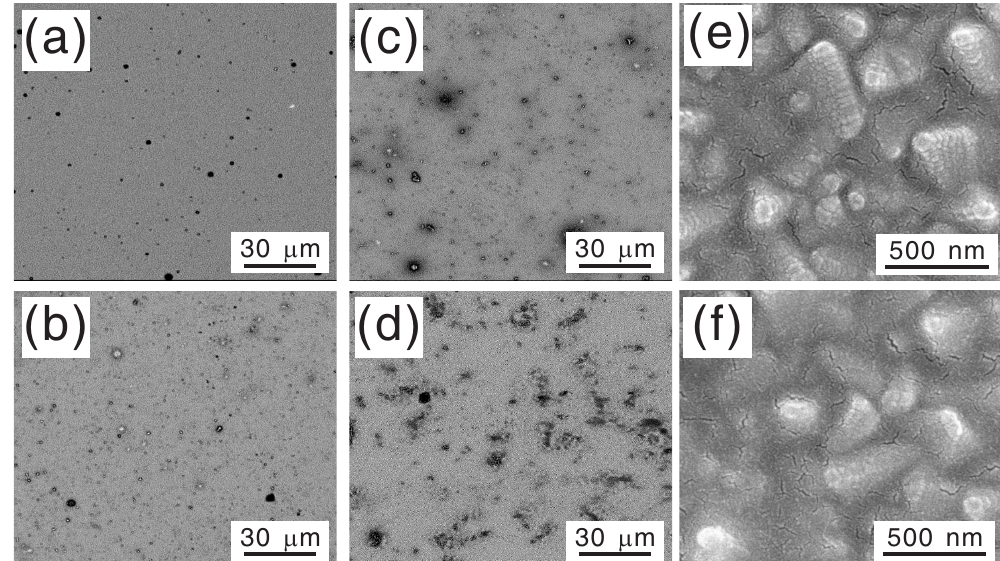
Figure 3. Top-view SEM images of Ni x Fe 1 − x O y /hematite photoanodes grown with various immersion times: ( a ) 0 s, ( b ) 48 s, ( c ) 96 s, and ( d ) 2 min. ( e , f ): high-resolution images of the bright region taken with field-emission SEM (FE-SEM) for the cases with an immersion time of 2 min and 20 min, respectively. The Ni-to-Fe ratio of the precursor was 8:2.